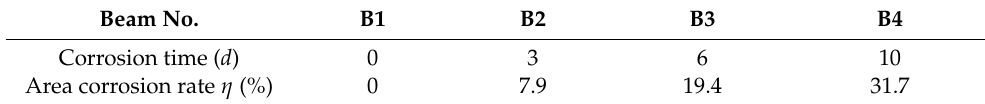
Table 2. Corrosion time and corrosion rate η .